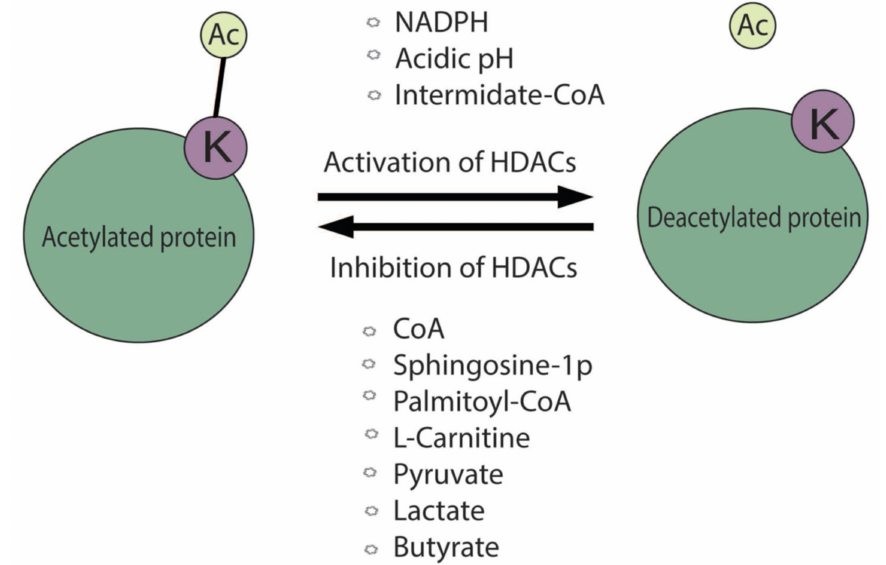
Figure 3. The role of metabolites a ff ecting HDAC activity. In normal conditions, HDACs leads to the removal of the acetyl group from lysine from the target proteins. This reaction is modulated by the described metabolites or physical factors via the activation or inhibition function of HDAC